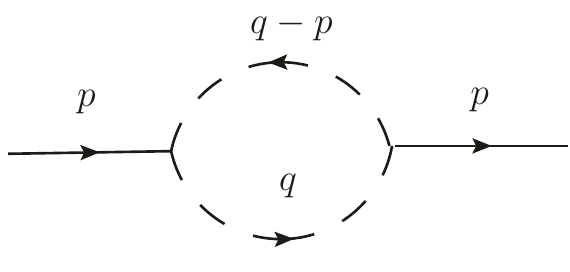
Figure 13. This diagram de(cid:12)nes ~ S 2 ( p ) in